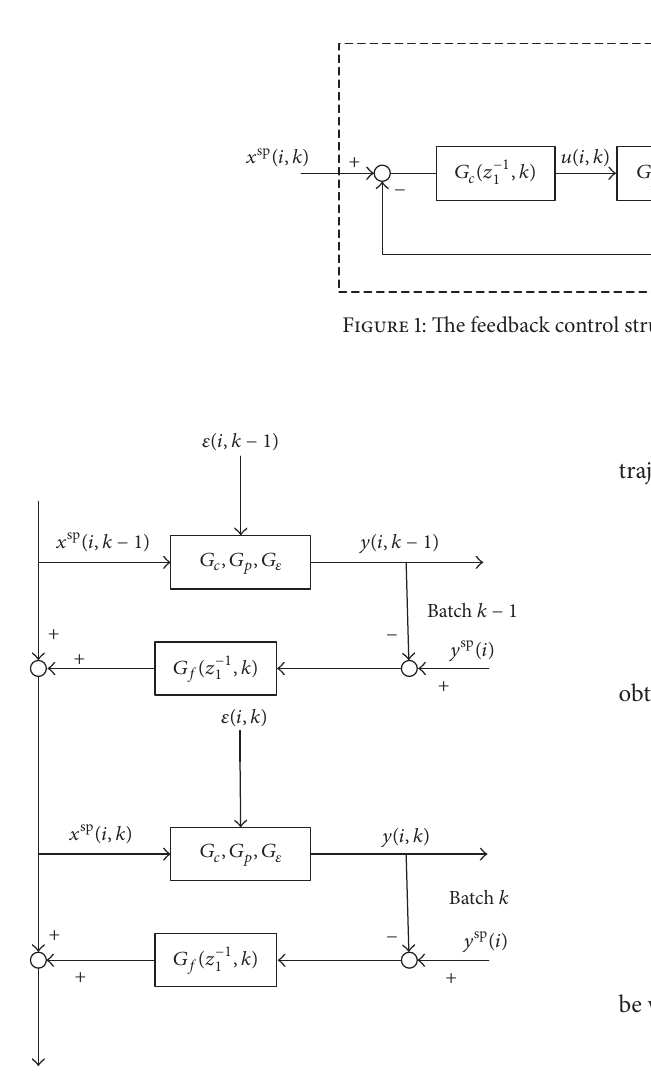
Figure 2: The schematics of ILC with the feedback controller (𝑧 −1 , 𝑘)) and the feedforward controller (𝐺 (𝐺 𝑐 1